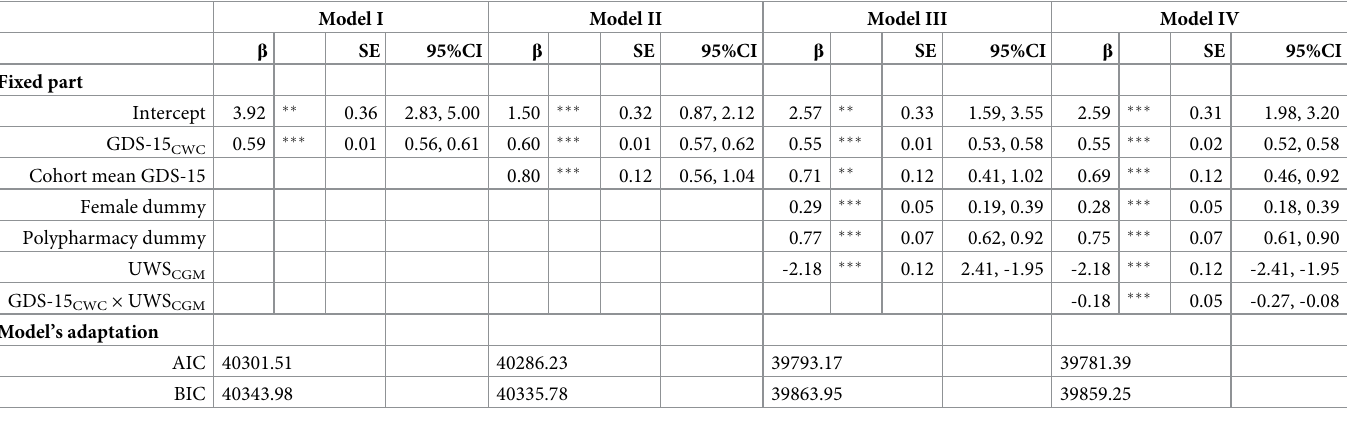
Table 4. Result of random intercept model with a dependent variable of KCL total